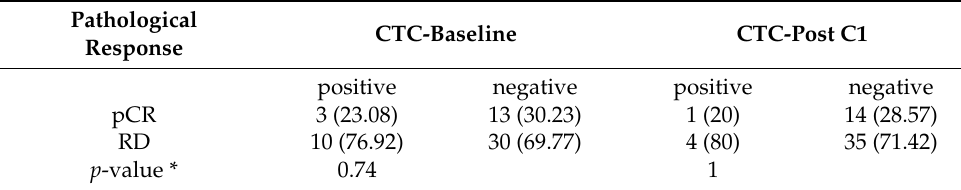
Table 3. Correlation between CTC and pathological complete response. Data are expressed as N (%). pCR: pathological complete response, RD: residual disease, *: Fisher’s exact tests.